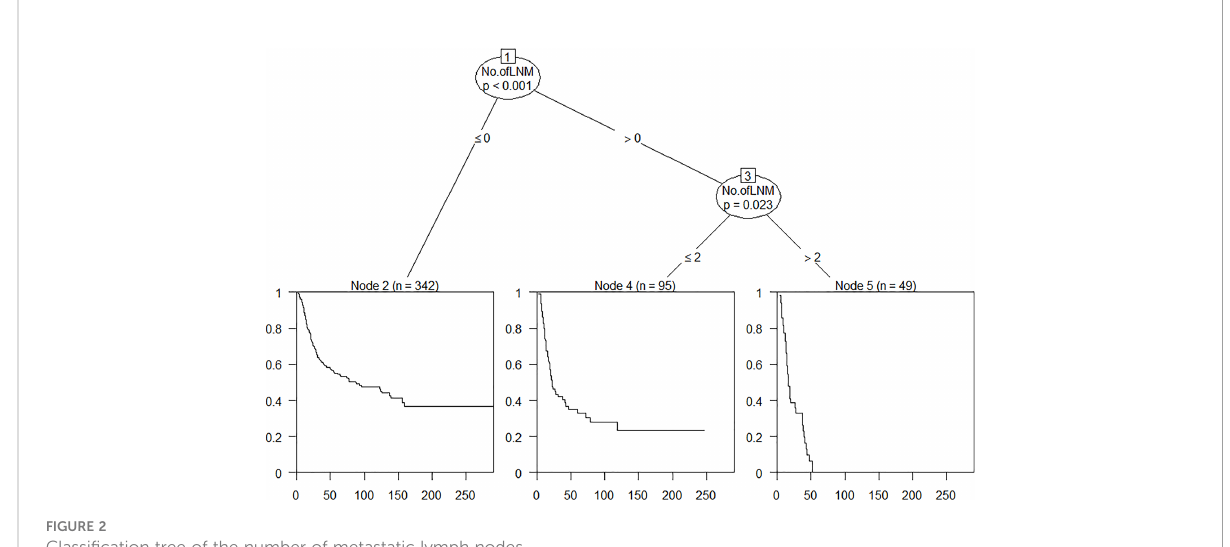
FIGURE 2 Classi fi cation tree of the number of metastatic lymph